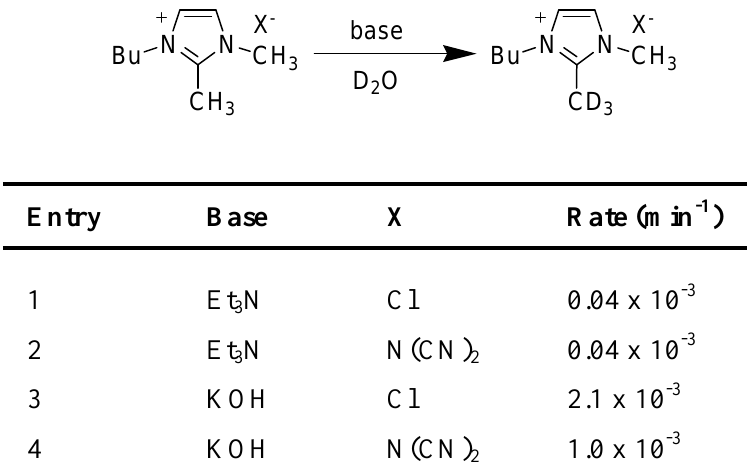
Table 4. Effect of anion on the H-D exchange rate of C2 methyl group of [bdmim]